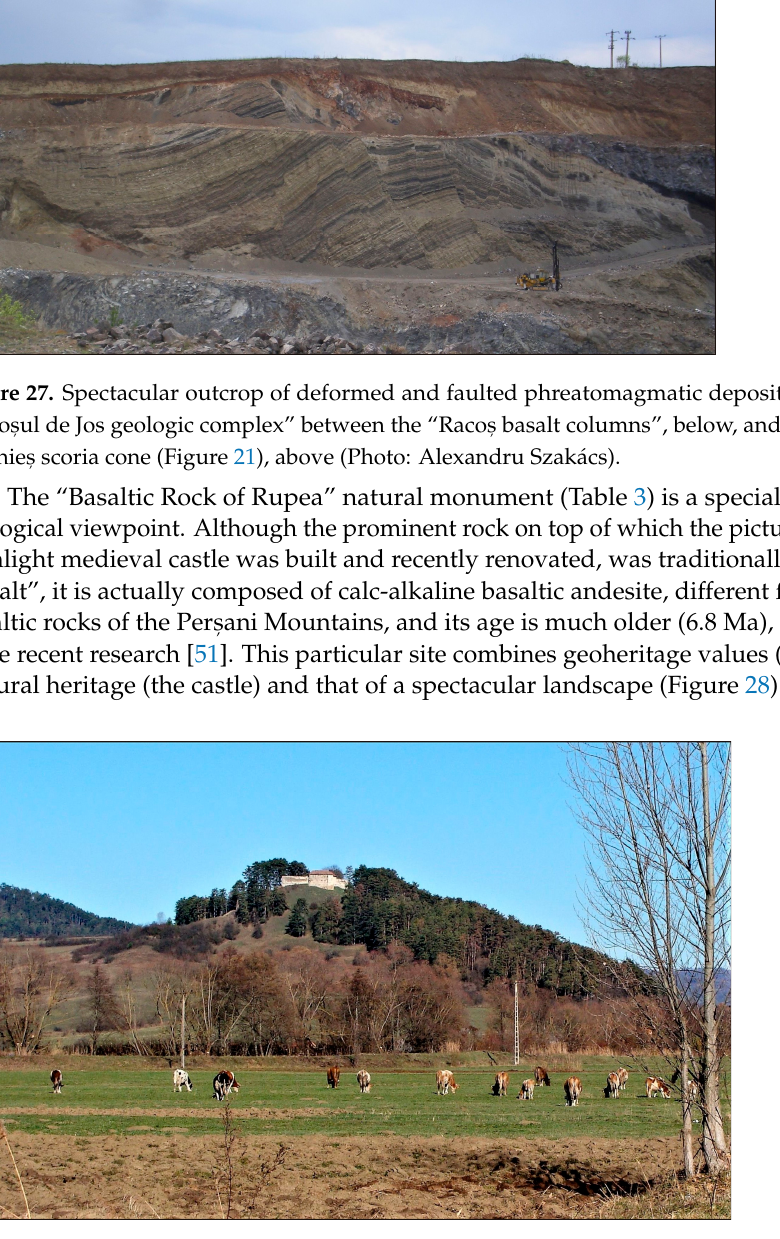
Figure 28. The “Rupea rock” with the Rupea castle on its top (Photo: Alexandru